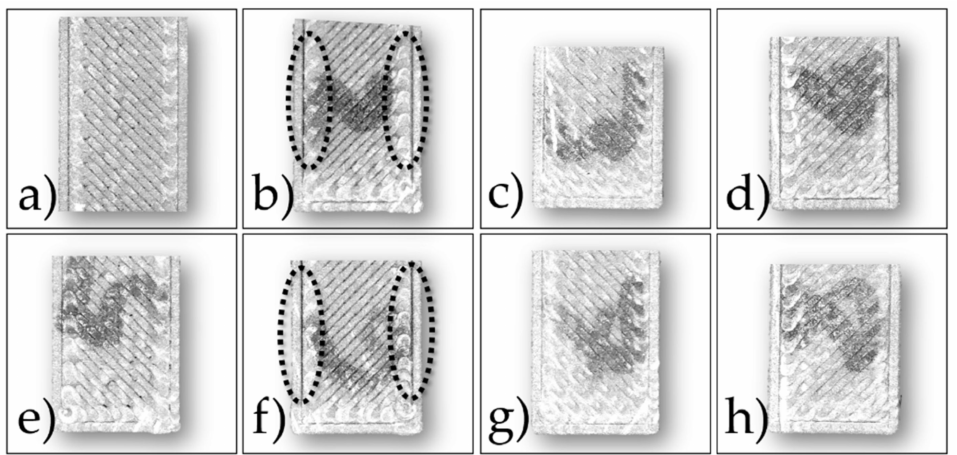
Figure 4. Optical images of green samples top surfaces printed according to the eight configurations in Table 3: ( a ) Nr. 5; ( b ) Nr. 4; ( c ) Nr. 1; ( d ) Nr. 2; ( e ) Nr. 7; ( f ) Nr. 8; ( g ) Nr. 6; ( h ) Nr.